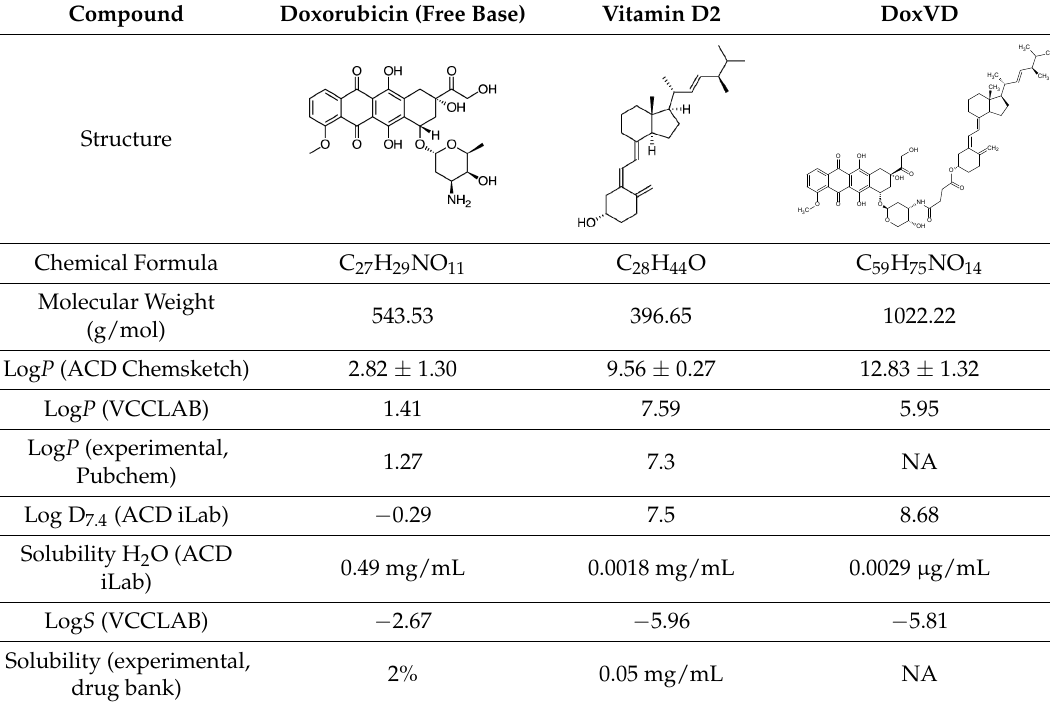
Table 2. Physicochemical properties of DoxVD vs Dox and Vitamin D2. Doxorubicin Compound (Free Base)